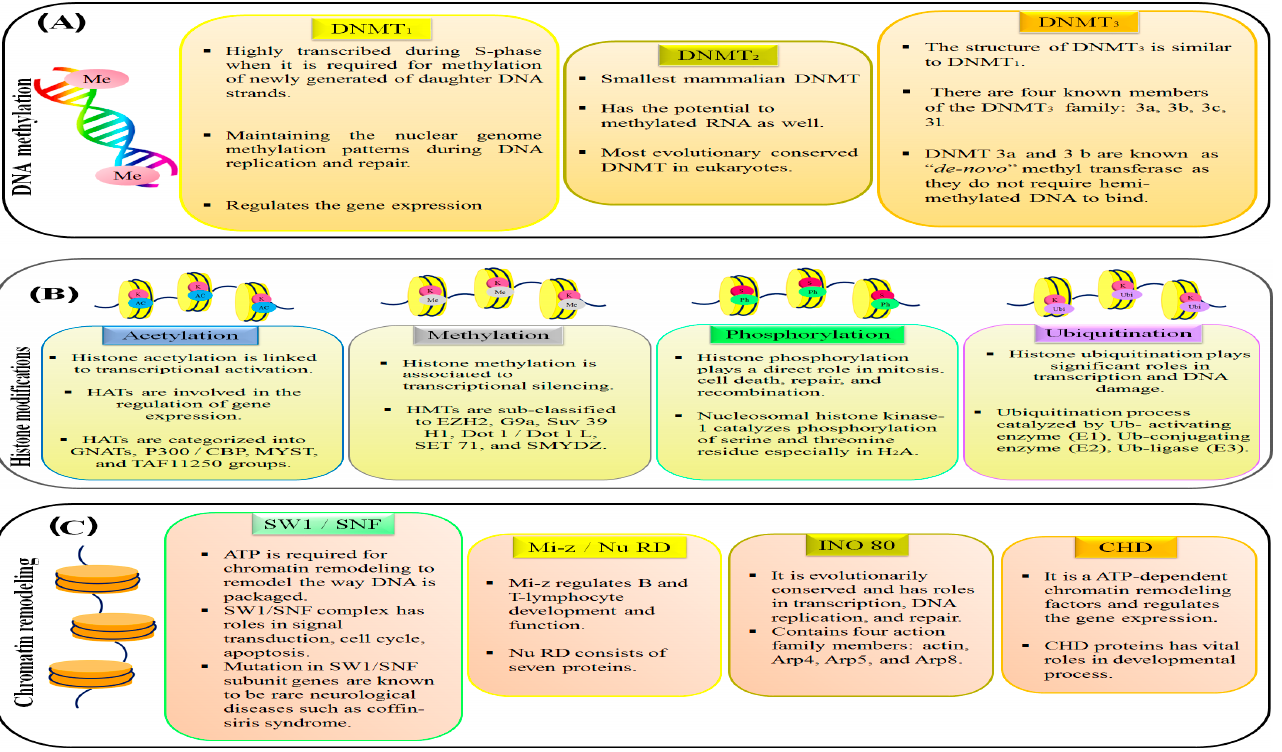
Figure 2. Selected examples of the possible interactions between the various epigenetic factors, such as DNA methylation ( A ), histone marks, ( B ), and nucleosome positioning ( C